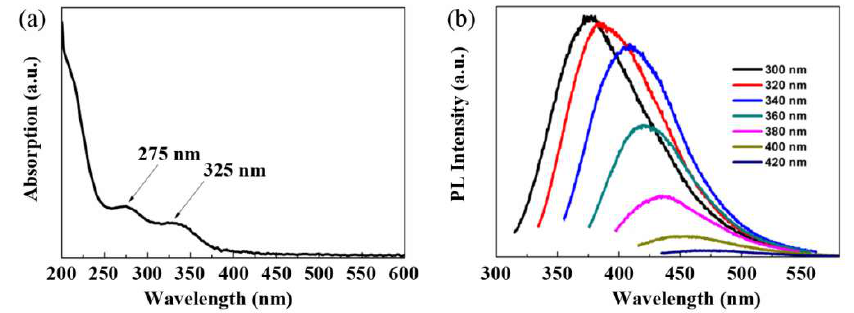
Figure 4. Optical properties of CNDs aqueous dispersion. UV-vis absorption spectrum ( a ), and PL emission spectra ( b